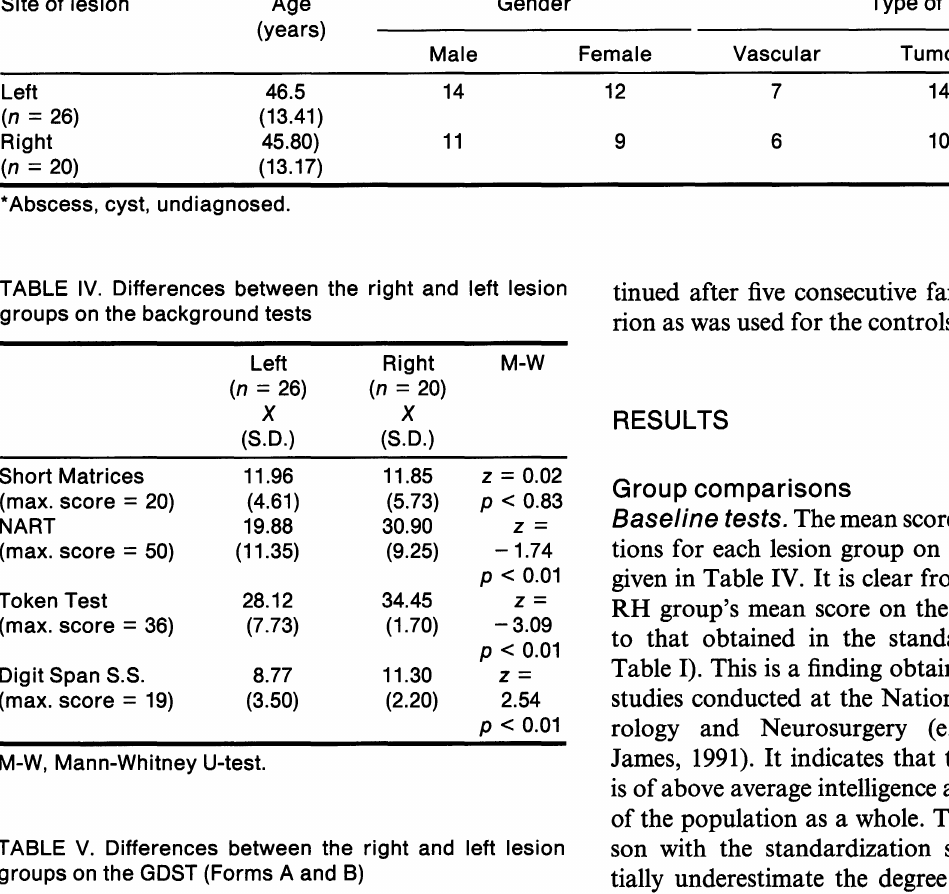
TABLE III. Characteristics of the lesioned sample Site of lesion